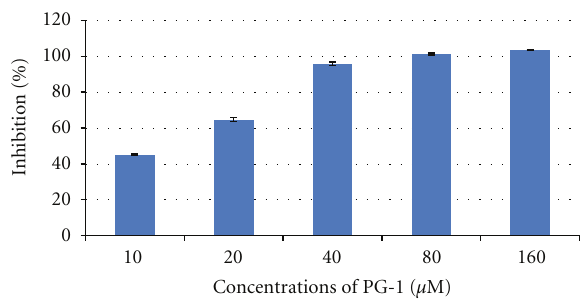
Figure 2: Dengue protease inhibition assay. The reaction mixtures consisted of fluorogenic peptide substrate and NS2B-NS3pro, with or without PG-1 of varying concentrations. The PG-1 was initially prepared in Tris-HCl bu ff er and assayed at five di ff erent concen- trations, 10–160 μ M. The best inhibition with low concentration of PG1 was observed at 40 μ M with 95.7% inhibition.